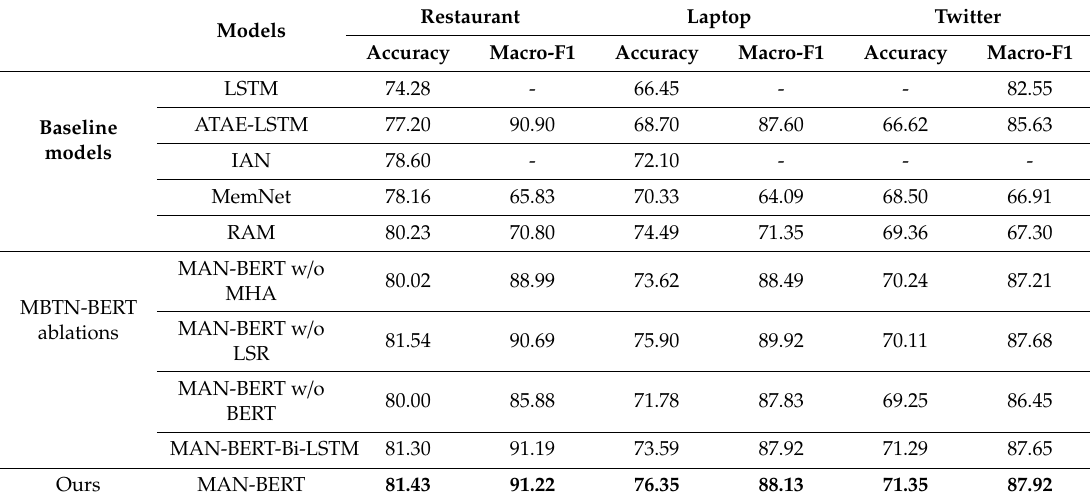
Table 2. Comparison with accuracy and macro-F1. “-” denotes not reported. Best results are in bold.